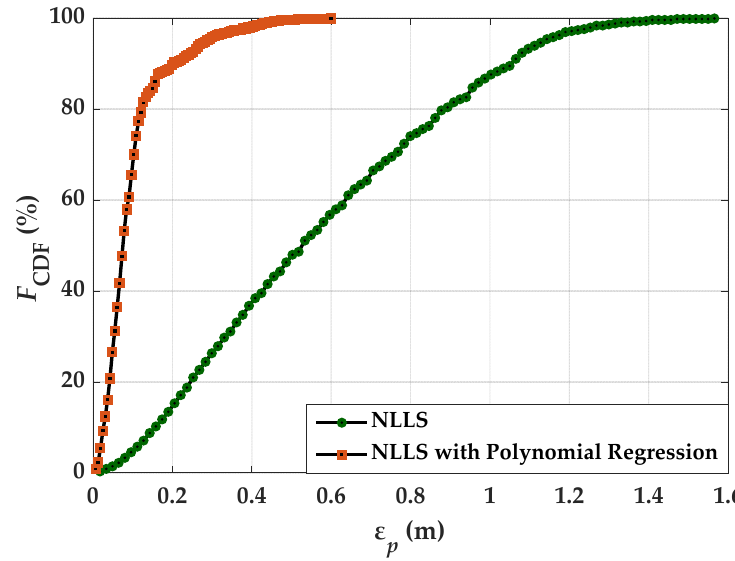
Figure 5. CDF of the ε p computed by NLLS and NLLS with polynomial regression estimation.